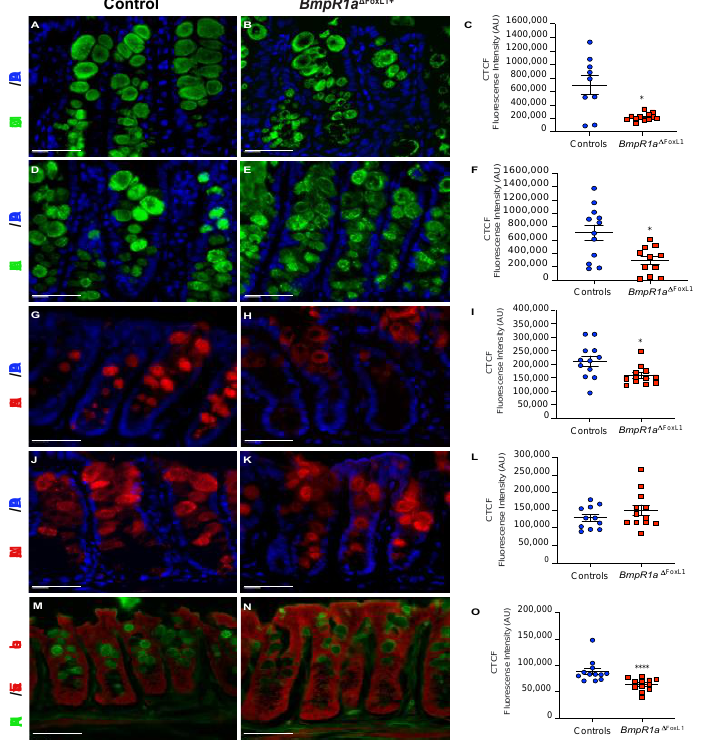
Figure 4. Loss of BMP signalling in telocytes promotes abnormal MUC2 localisation within secretory vesicles and reduces mucin maturation. ( A ) Control mice presented well-filled mucin vesicles ( B ) whereas BmpR1a ∆ FoxL1+ mice showed abnormal mucin (green) deposition at the periphery of the vesicles. ( C ) Intensity measurements across goblet cells (middle vs. periphery) validated the peripheral deposition of MUC2 in the mutant mice. ( D ) Control mice presented normal levels of mucin fucosylation (green) while ( E ) BmpR1a Δ FoxL1+ mice revealed a decrease in mucin fucosylated residues. ( F ) Intensity measurements across goblet cells validated decreased mucin fucosylated residues in mutant mice. ( G ) Control mice presented homogenous expression pattern for sialic acid modifications (red) in mucins whereas ( H ) BmpR1a Δ FoxL1+ mice presented a peripherical deposition in the vesicles. ( I ) Intensity measurements across goblet cells validated reduction in patterns of sialic acid modifications in the mutant mice. ( J ) Control mice revealed an orderly staining pattern for sialic acid residues (red) in vesicles while ( K ) BmpR1a ∆ FoxL1+ mice showed scattered distribution and reduced expression. ( L ) Intensity measurements across goblet cells confirmed no modulation in patterns of sialic acid residues between both groups. ( M ) Control mice presented normal vesicles pattern for terminal galactose β 1,3 GalNAc residues (green) whereas ( N ) BmpR1a ∆ FoxL1+ mice showed accumulation of the residues at the periphery of vesicles. ( O ) Intensity measurements across goblet cells confirmed a reduction in terminal galactose β 1,3 GalNAc residues in mutant mice. Nuclei were counterstained with DAPI (blue); ( M , N ) were counterstained with Evan’s blue (red) ( N = 4). Scale bar: 450 μm. * p < 0.05; **** p < 0.0001 analysed by Mann – Whitney test.